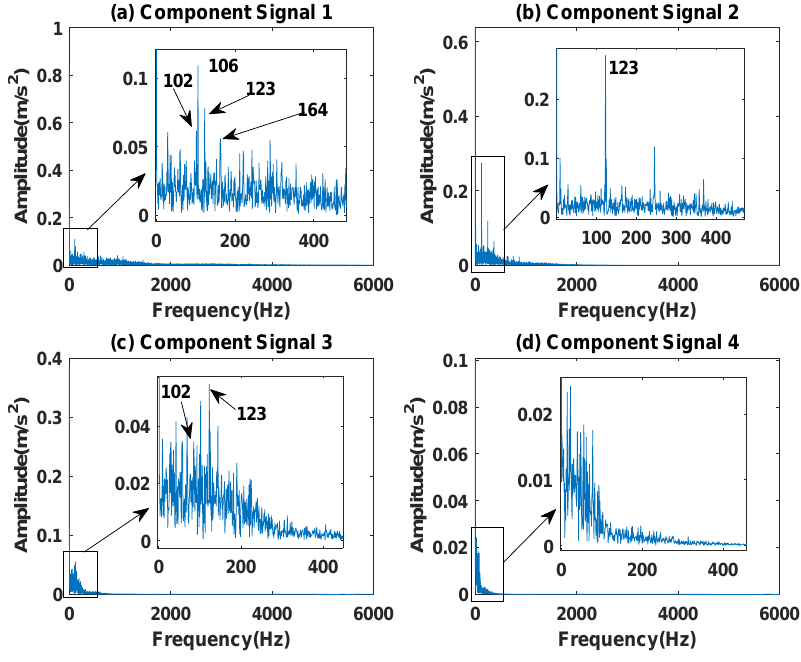
Figure 26. Decomposition results of EMD with m = 16: ( a – d ) envelop of 1st to 4th subcomponents, respectively.